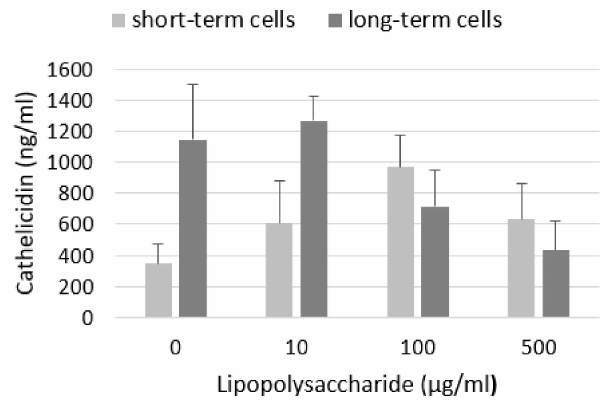
Figure 5. Level of cathelicidin LL-37 in A549 cell lysates. LPS increased level of LL-37 in short-term cells. Long-term cells produce more LL-37 than short-term cells and its level was slightly increased by low concentration of LPS and decreased after treatment with higher concentrations of LPS. Data are presented as means ± SDs from three independent experiments.